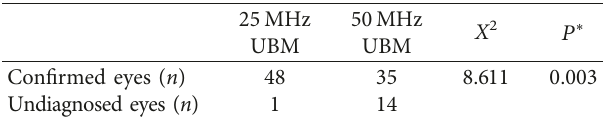
Table 2: Diagnostic accuracy comparison between 25MHz and 50MHz UBM.